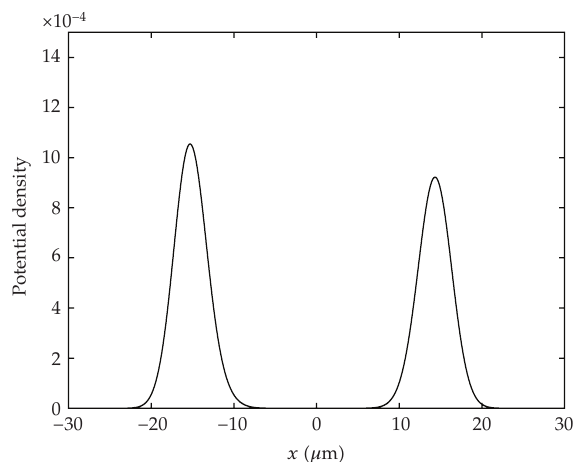
Figure 6: The probability density for the ballistic electron after entanglement (cid:9) t (cid:7) 445ps (cid:10) for the qubit in √ initial state | (cid:8) (cid:2) ≡ (cid:9) | 0 (cid:2) (cid:8) | 1 (cid:2) (cid:10) / 2 using an initial energy of 1.585meV and the optimised barrier parameters.